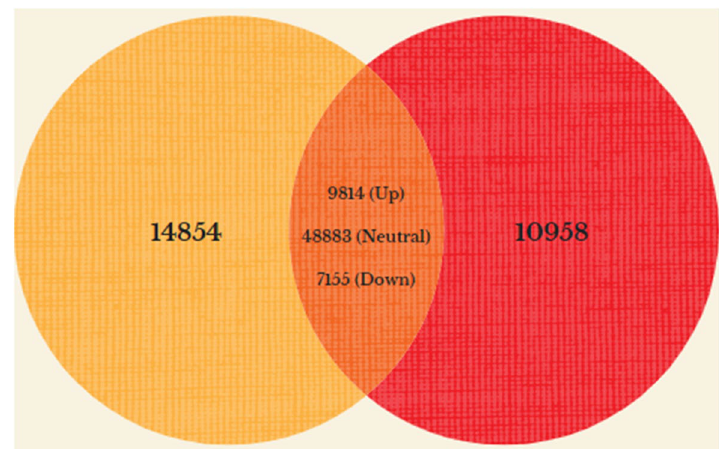
Fig. 2 Venn diagram showing the number of up-regulated, down-regulated, neutral and unique transcripts